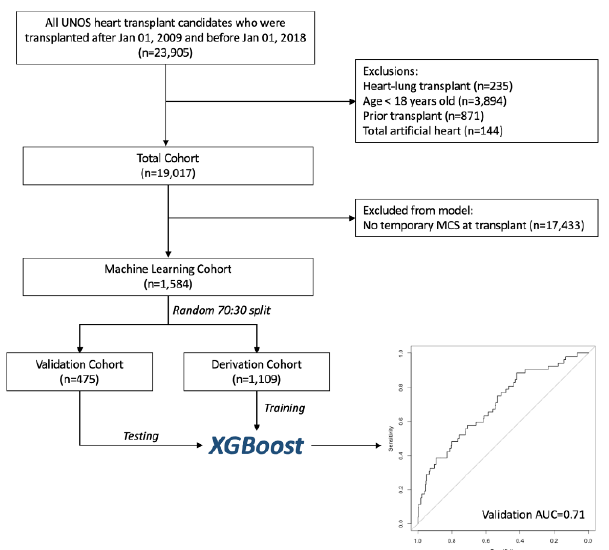
Figure 1. Flow diagram showing inclusion and exclusion criteria for this study’s cohort. UNOS: United Network for Organ Sharing; MCS: mechanical circulatory support.